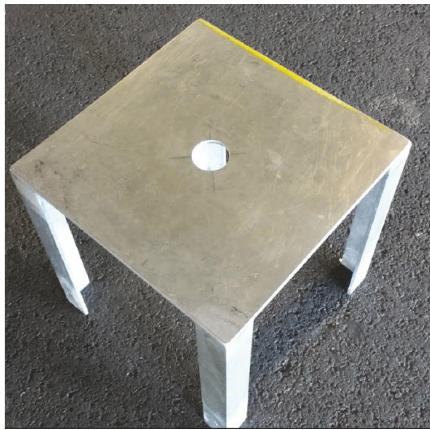
Figure 1: Image capturing